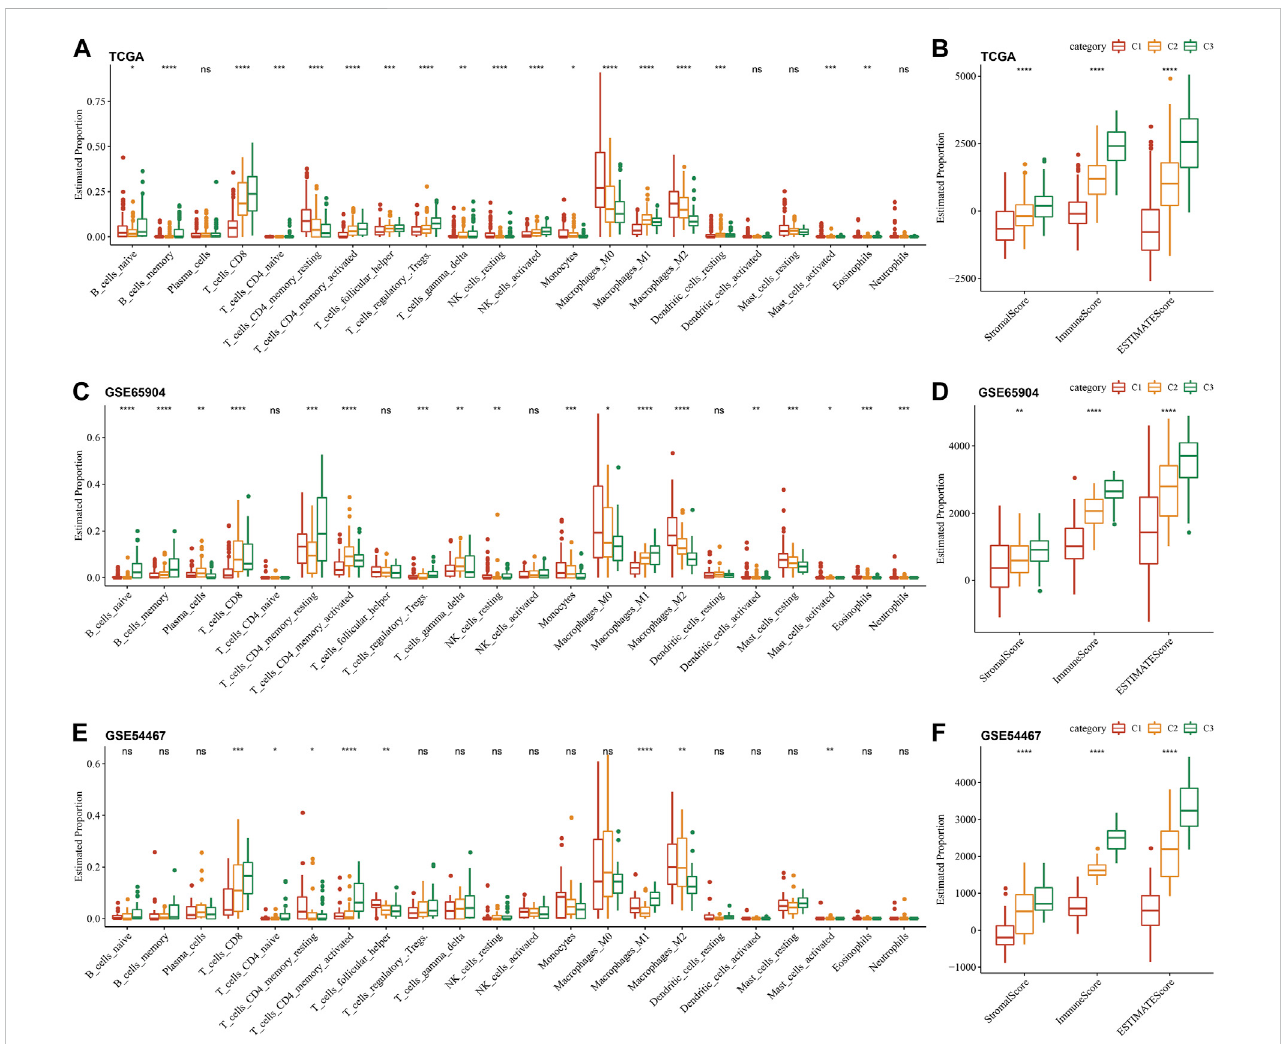
FIGURE 6 Immune characterization of different molecular sub-types. (A – F) : Differences in immune cell in fi ltration between different molecular subtypes in CIBERSORT and ESTIMATE in the three cutaneous melanoma cohorts.